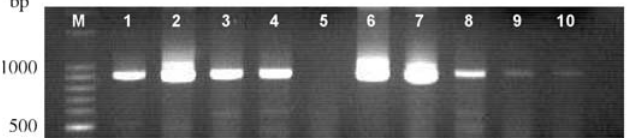
Fig. 1. Agarose gel electrophoresis of RT-PCR ampli- fi cations of the coat protein from ten BYMV isolates in faba bean. Lane 1. SV205-85 (Syria); 2. SUV254-88 (Sudan); 3. EV34-91 (Egypt); 4. LYV61-91 (Libya); 5. YeV48-96 (Yemen); 6. ATCC PV89 (USA); 7. G (Nether- lands); 8. AUV8-04 (Australia); 9. ChV657-04 (China); 10. JV175-96 (Jordan). M, 100 bp Ladder DNA marker (Real Biotech Corporation, Taiwan).